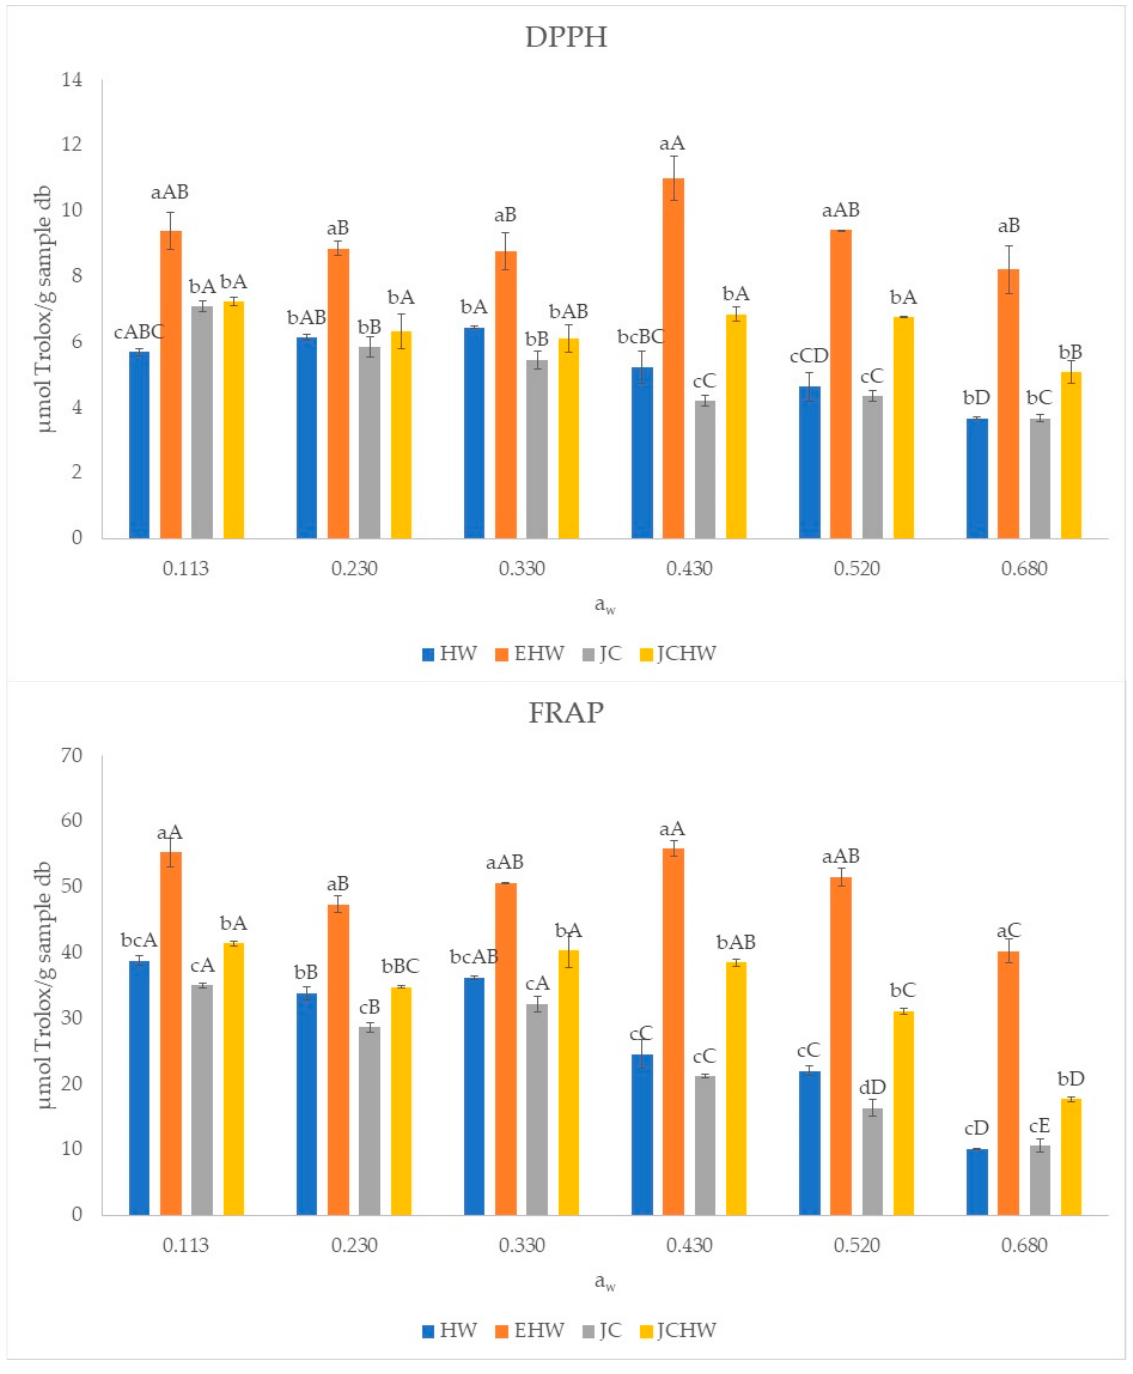
Figure 5. Antioxidant capacity of the samples (DPPH and FRAP) at different water activities. HW: hot water; EHW: extrusion + hot water; JC: jet cooker; JCHW: jet cooker + hot water. Different small letters for the same a w indicate significant difference according to Tukey test ( p < 0.05) between treatments. Different capital letters in the same treatment indicate significant difference according to Tukey test ( p < 0.05) between water activities.